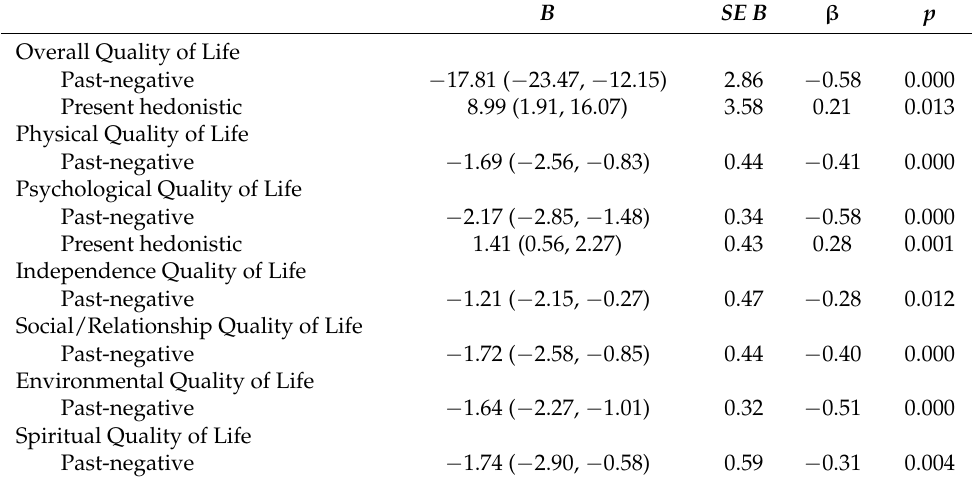
Table 2. Significant linear model of predictors of overall and individual domains of QoL with 95% bias corrected and accelerated confidence intervals reported in